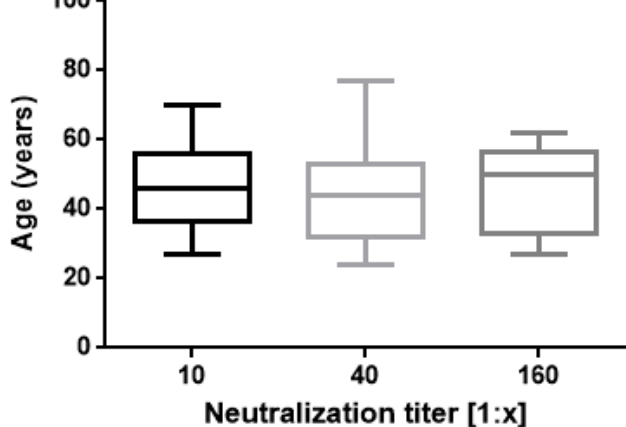
Figure 2. Neutralization titres 30 days after second vaccination are shown. Boxes span the interquar- tile range; the line within each box denotes the median and whiskers indicate the 25 and 75 percentile values (one way ANOVA, p = 0.5 ns).